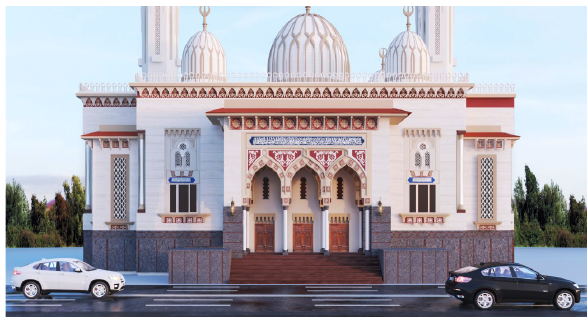
Figure 15. 3D model of the façade with surface